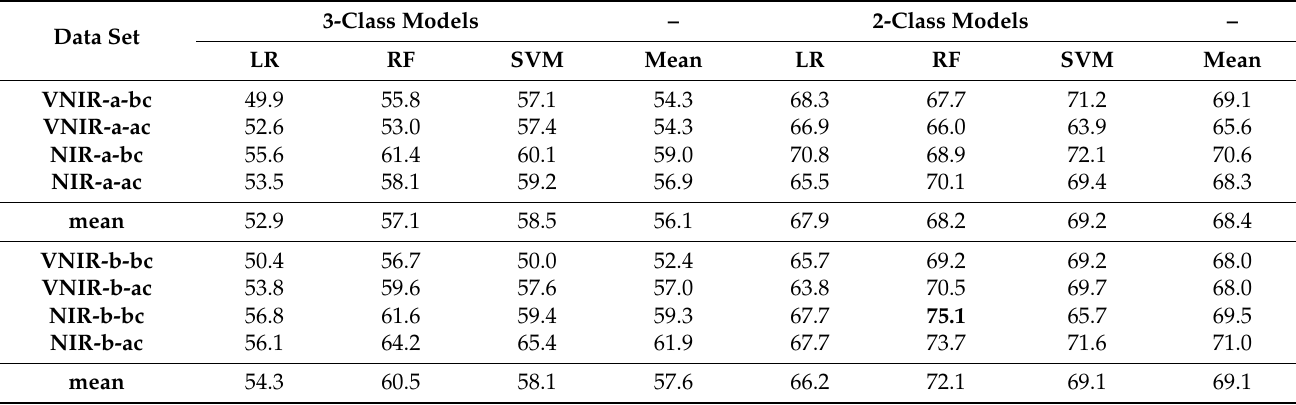
Table 2. 10-fold cross-validated overall balanced classification accuracies for the prediction of the cross-section classes from the spectra of the HSI measurements in percent. The calculation was performed for three or two cross-cut classes. The best accuracy is marked in bold. 3-Class Models 2-Class Data Set